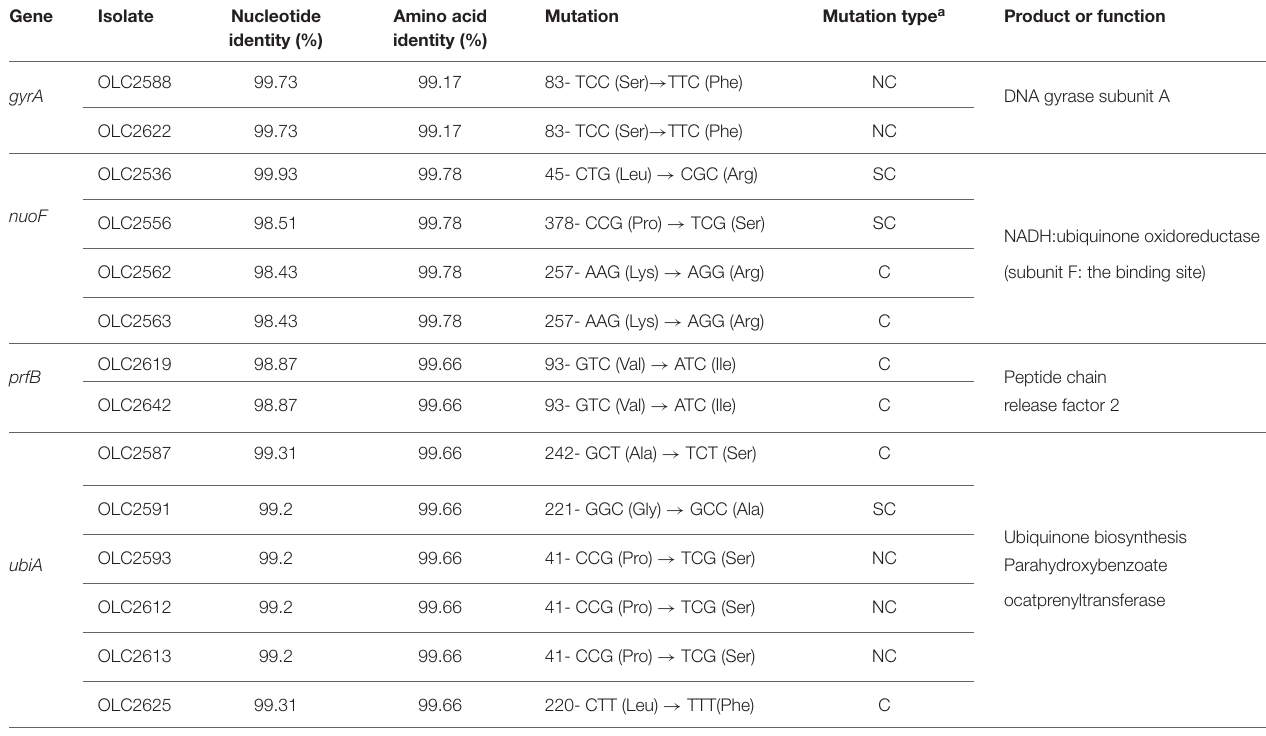
TABLE 2 | Identification of single nucleotide variations resulting in non-synonymous